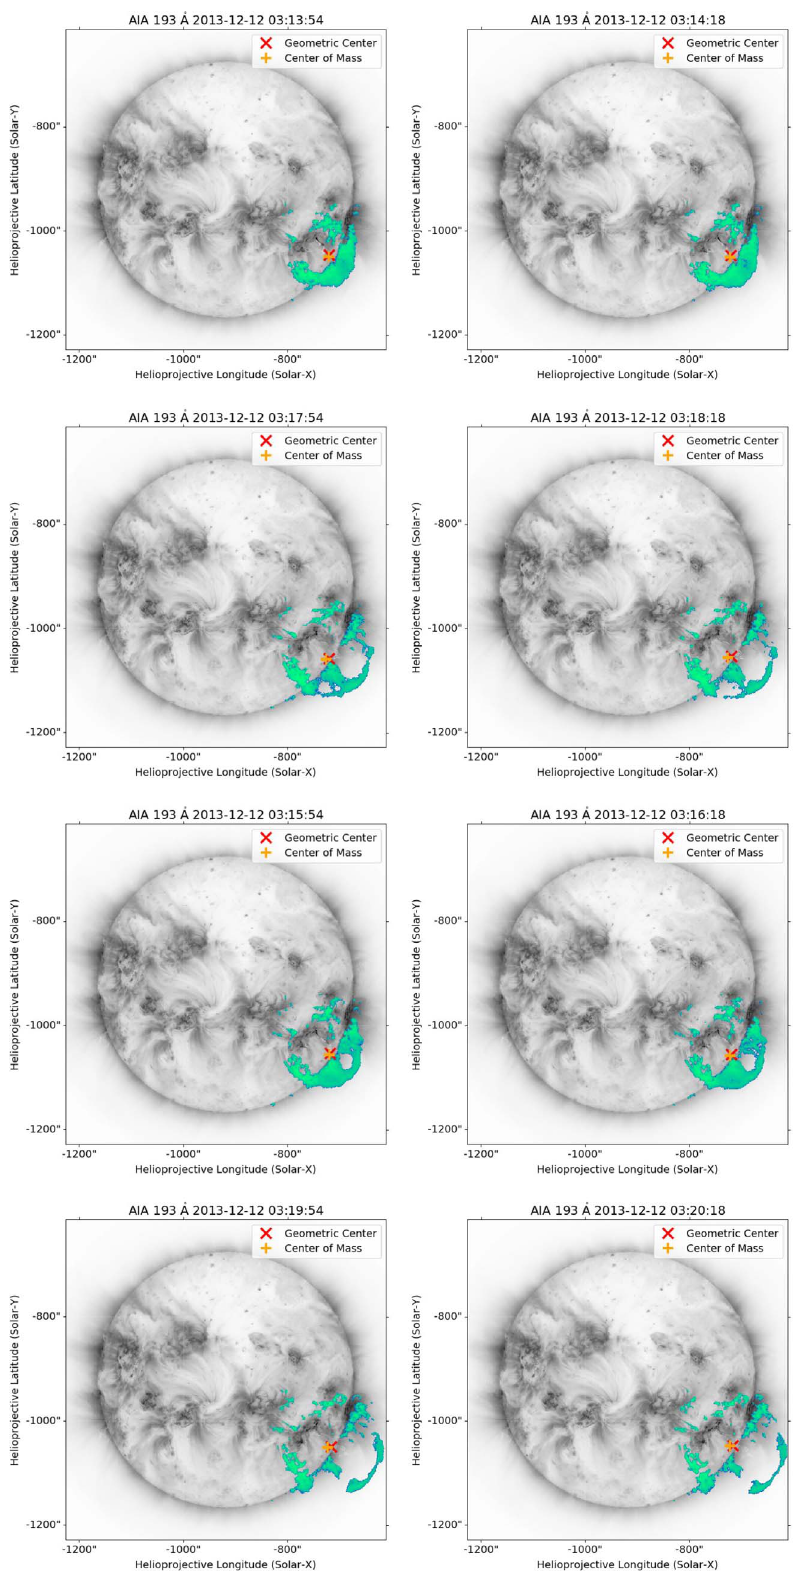
Fig. 11. The wavetrack output for four pairs of consecutive images separated by 2 min during the eruption of December 12, 2013, similar to Figure